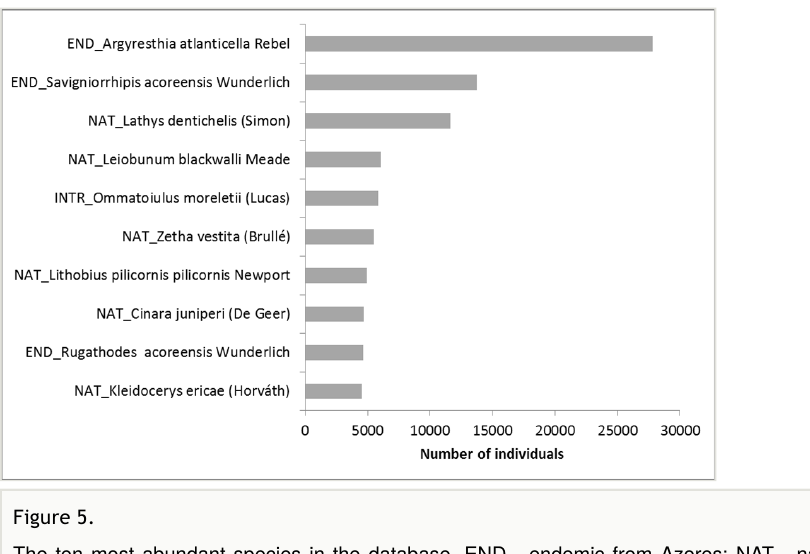
The ten most abundant species in the database. END - endemic from Azores; NAT - native non-endemic species; INTR - species introduced in the archipelago.